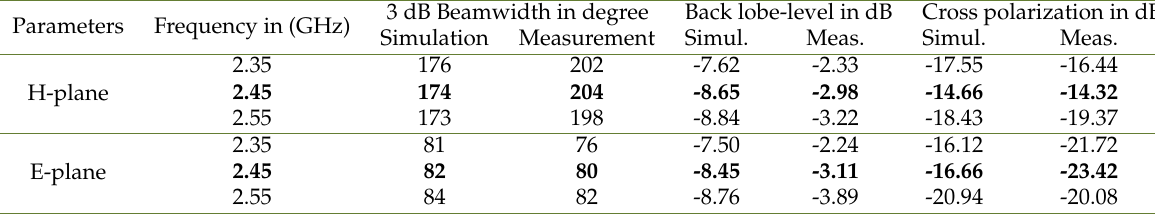
Table 1. Performance efficiency of our designed 3 r d order dipole antenna-filter Parameters